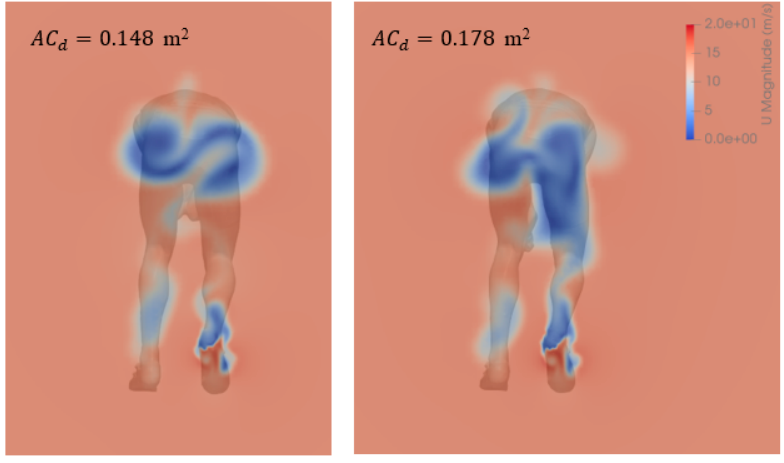
Figure 5. Slice plot of velocity magnitude right behind the cyclist body. Left: Base position. Right: Maximum elbow extension.